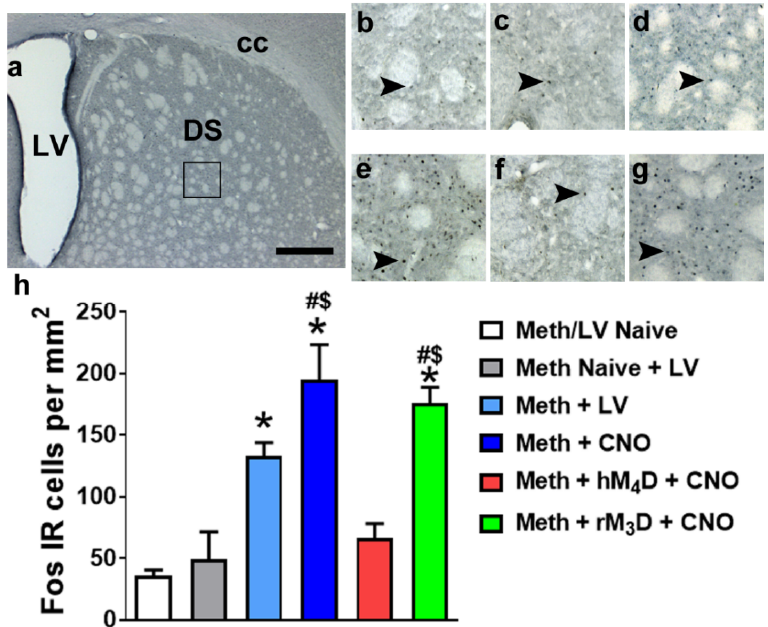
Figure 3. ( a ) Photomicrograph of a dorsal striatal section stained with Fos indicating the area